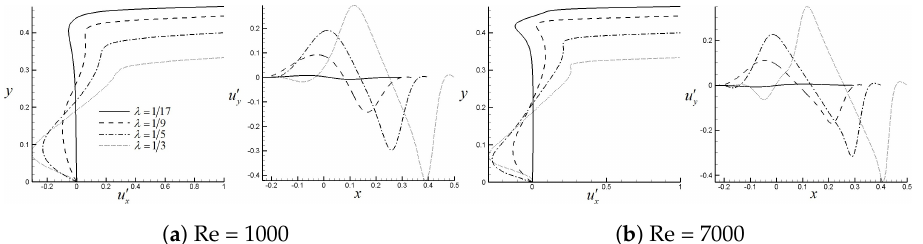
Figure 13. Normalized velocity profiles along the vertical and horizontal central lines for different values of λ